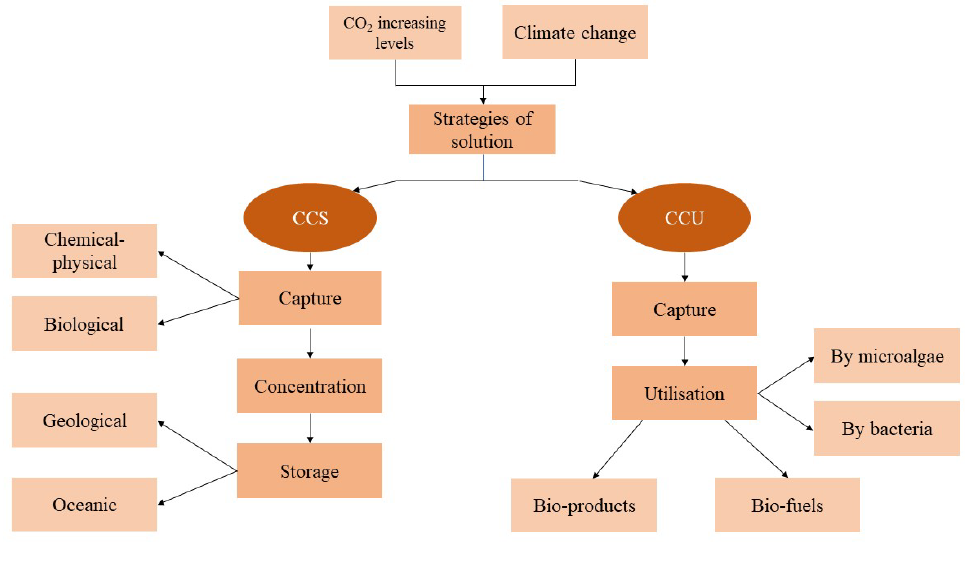
Fig. 1. Scheme of two possible solutions to limit CO 2 increasing levels: CCS and CCU technologies with different processing